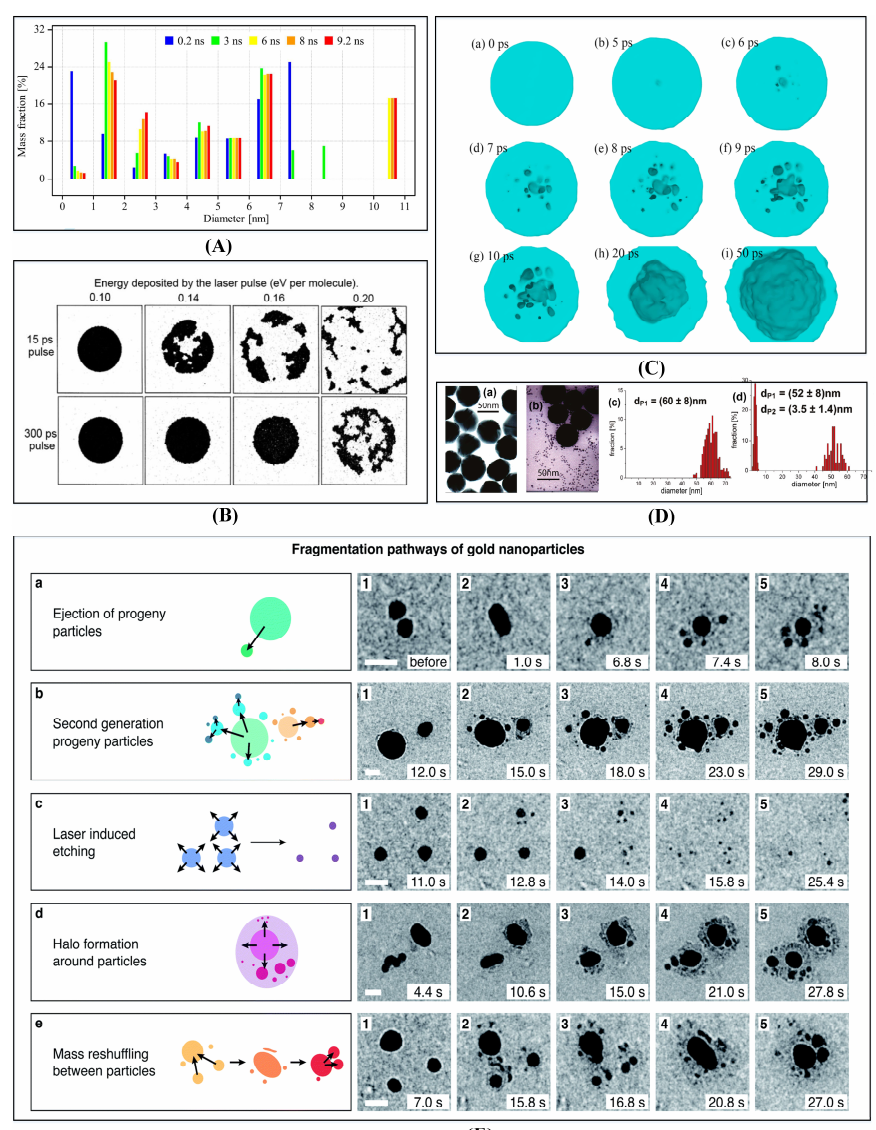
Figure 6. Simulation and experiments of laser fragmentation in liquid. ( A ) The total mass of nanoparticles with various diameters by a simulation of LFL of a 20 nm gold nanoparticle irradiated by a 10 ps laser pulse at a deposited energy density of 2.7 eV/atom [25]. Reprinted with permission from Ref. [25]. Copyright 2021 American Chemical Society. ( B ) Snapshots of LFL from MD simulations of laser irradiation of individual particles (~100 nm) versus deposited laser energy [32]. Reprinted with permission from Ref. [32]. Copyright 1998 Elsevier. ( C ) Simulation of the creation of hollow silver NPs using MD (20 nm silver nanoparticle after heating for 50ps) [33]. Reprinted with permission from Ref. [33]. Copyright 2021 Elsevier. ( D ) TEM images and corresponding size distributions of 60 nm GNPs before ( a , c ) and after ( b , d ) of laser irradiation (at 1 kHz and an excitation wavelength of 400 nm) [31]. Reprinted with permission from Ref. [31]. Copyright 2011, copyright American